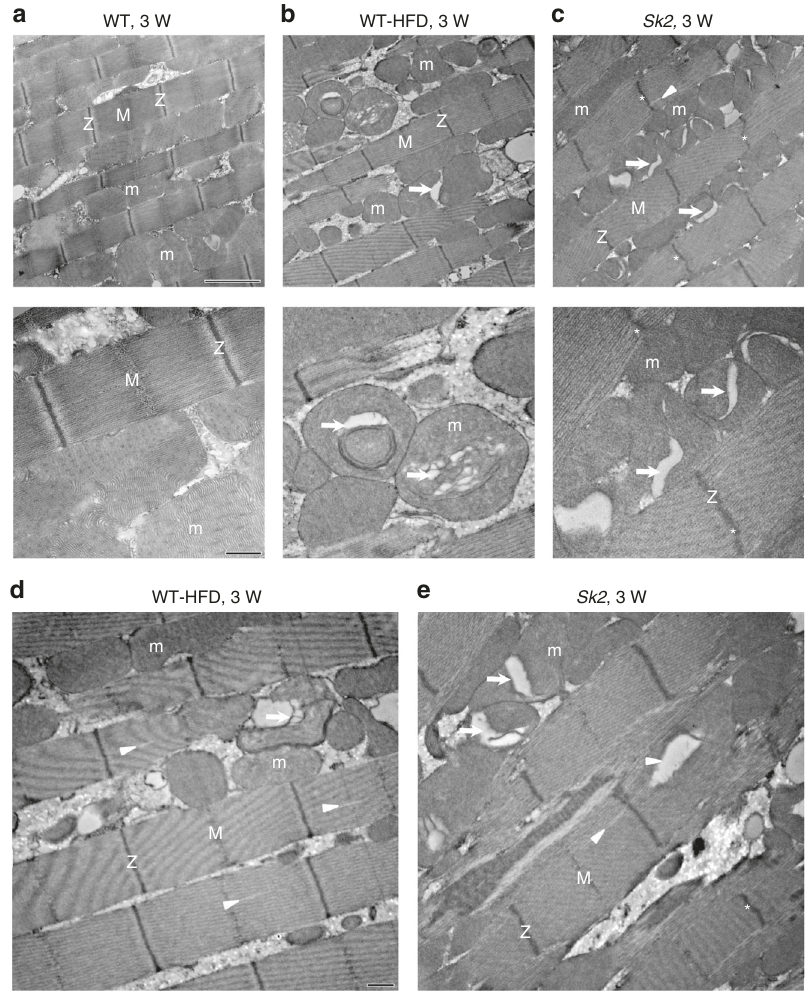
Fig. 2 Obesity caused abnormal myo fi brillar organization and mitochondrial defects. a – e Ultrastructural analysis using TEM revealed that obesity caused myo fi bril disorganization and mitochondrial abnormalities compared to wild-type CS under ALF in 3-week-old female fl ies IFM. Compared with control ( a ), occasional myo fi brils with partially intact Z-disks (Z) and M-lines (M) were observed ( b , d ) with the diet-induced obesity, which were more prominent in the genetic obesity mutant ( c , e ). Abnormal mitochondria (m, arrows) and disorganized myo fi brils (white arrowheads) were evident with diet-induced obesity. Genetic obesity also resulted in abnormal mitochondria (m, arrows), a more severe myo fi bril disorganization (white arrowheads) and resulted in wavy sarcomere and Z-disks (asterisks). No such abnormalities were seen in the age-matched control. Scale bar for the top a – c panels is 2 µ m and bottom a – c panels is 0.5 µ m. Scale bar for the panels d and e is 0.5 µ m. The quanti fi cation of obesity-induced myo fi brillar disorganization and mitochondrial abnormalities are shown in supplementary Fig.